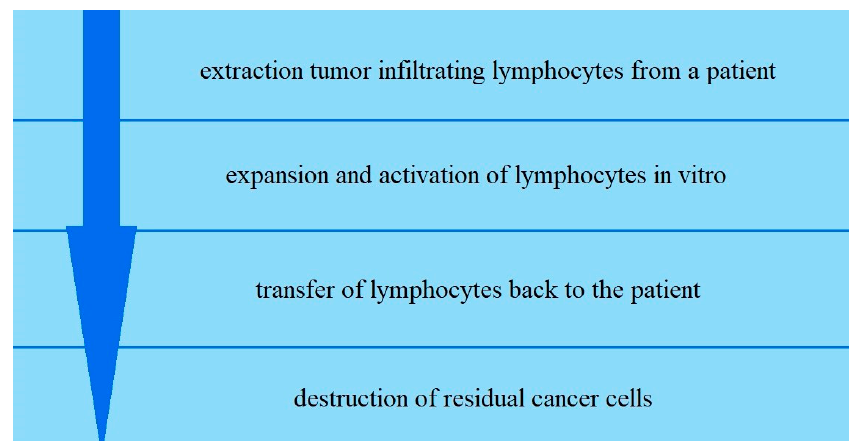
Figure 2 . Scheme of the process of adoptive cell therapy . Figure 2. Scheme of the process of adoptive cell